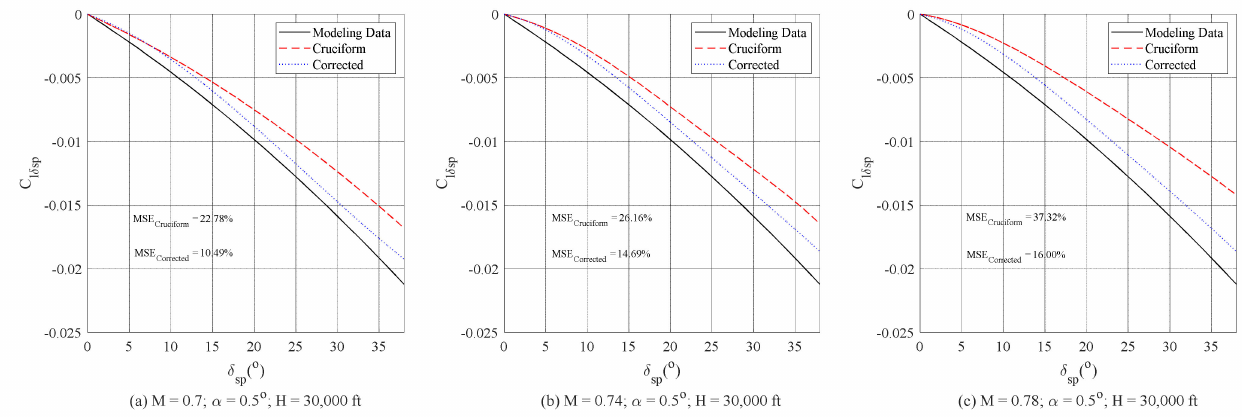
Figure 7. Comparison of the computation and experimental rolling moment coefficients in high-subsonic flight: ( a ) in the flight states of M = 0.7, α = 0.5 ◦ , and h = 30,000 ft; ( b ) in the flight states of M = 0.74, α = 0.5 ◦ , and h = 30,000 ft; and ( c ) in the flight states of M = 0.78, α = 0.5 ◦ , and h = 30,000